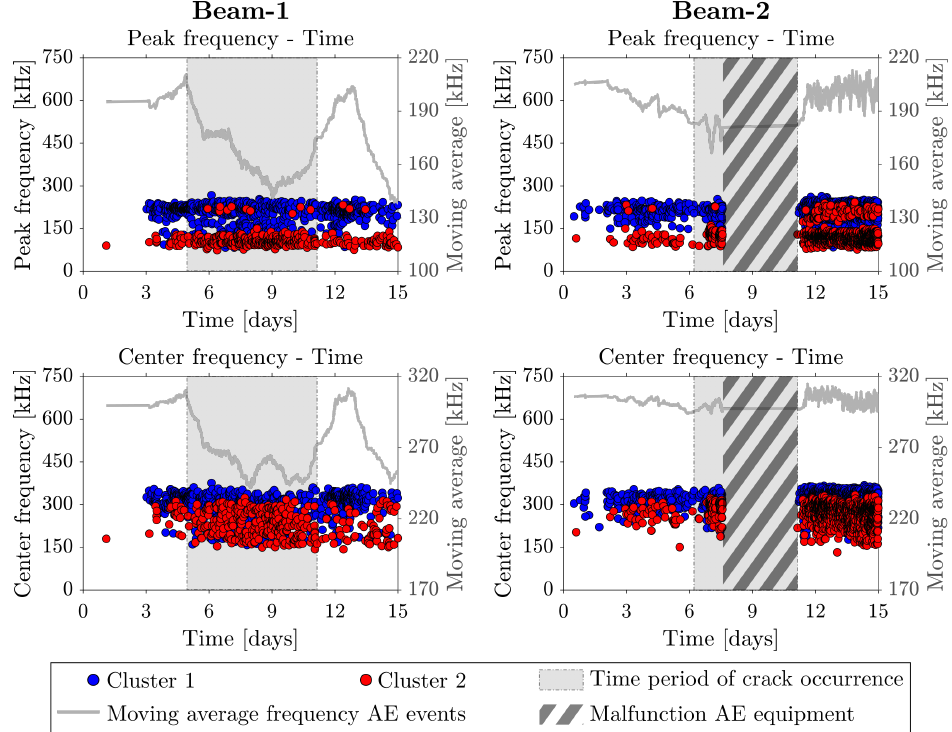
Figure 9. Clustering results for Beam-1 ( left ) and Beam-2 ( right ) represented as peak frequency ( top ) and center frequency ( bottom ) versus time. The period in which the surface crack occurred is indicated by the grey